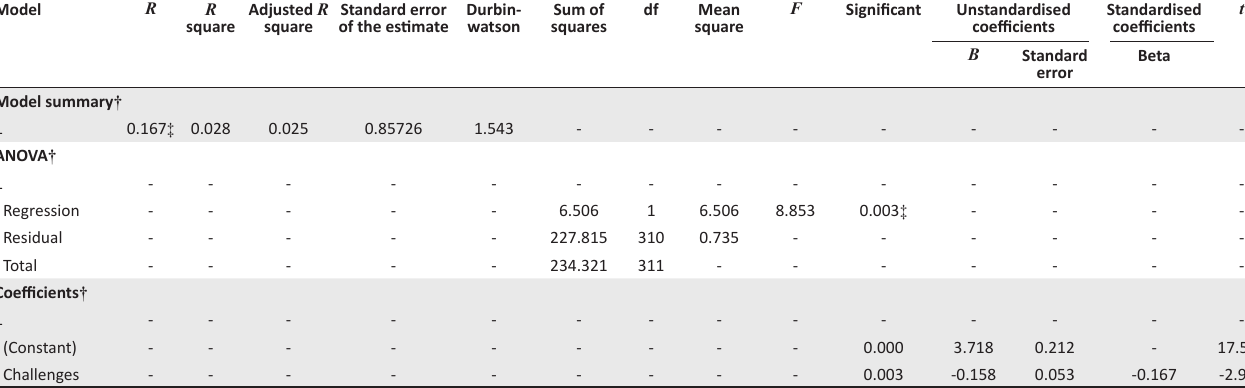
TABLE 6: Regression analysis: Challenges and digital human resource management practices. Model